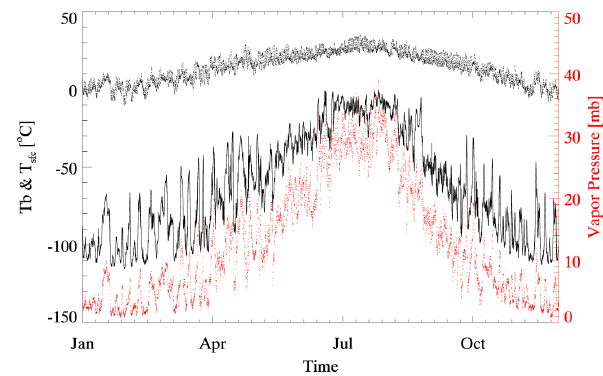
Figure 3. Time series of the simulated Tb (black solid line) along with T sfc (the surface air temperature; black dotted line, both tem- perature scales are on the left) and e (the surface water vapor pres- sure; red dotted line with the scale on the right) from 1 January to 31 December 2012. T sfc and e are the values at the lowest levels of the vertical profiles of temperature and humidity used for the radiative transfer